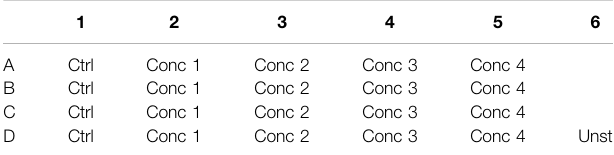
TABLE 7 | Plate con fi guration for treatment.